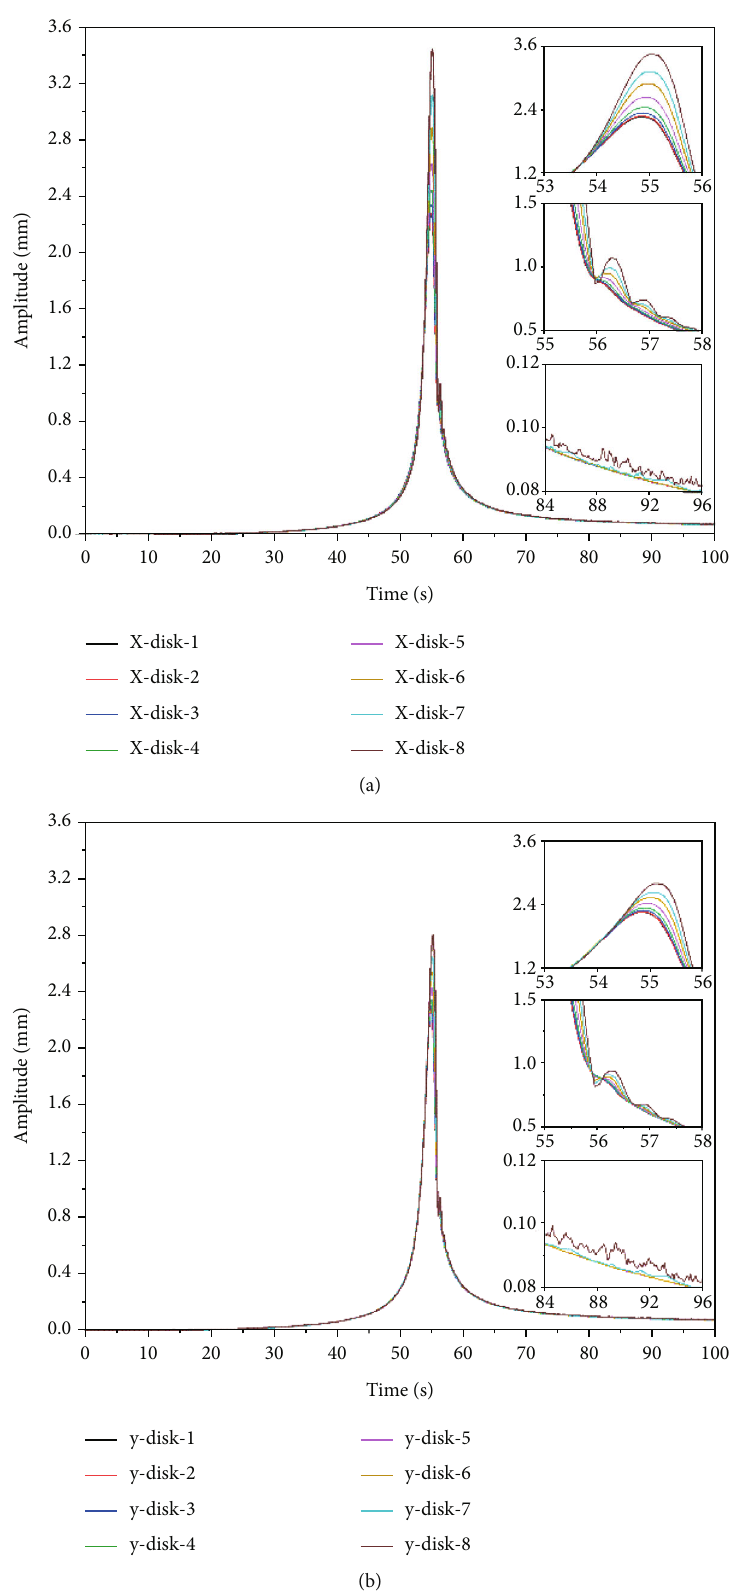
Figure 19: Variations of the node displacements at the disk during run-up process. (a) Response in the x -axis direction. (b) Response in the y -axis